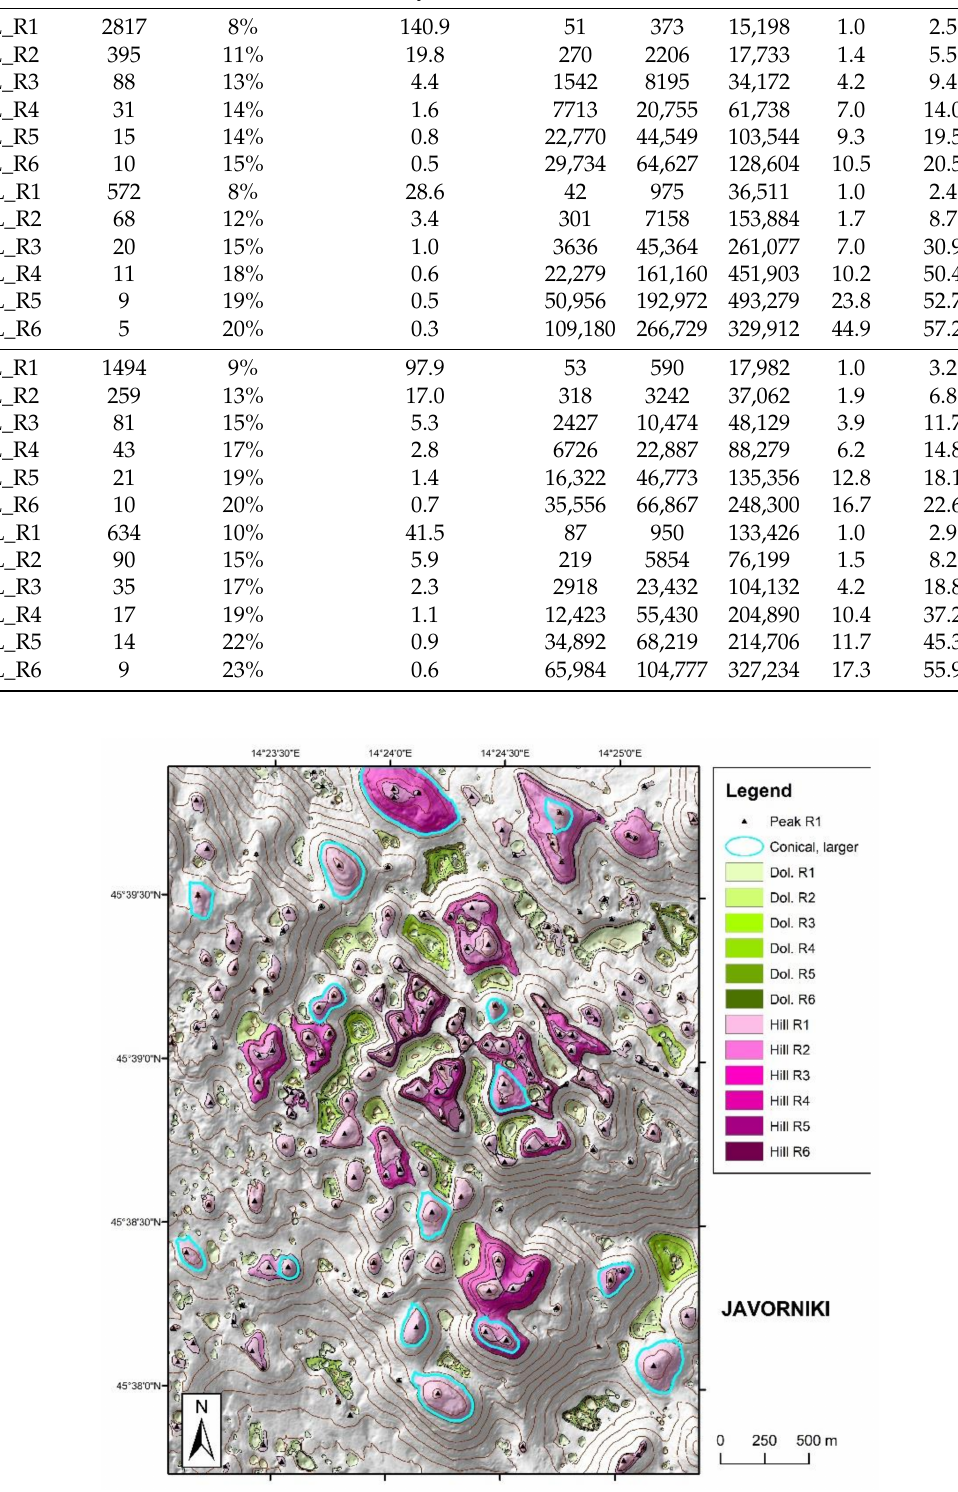
Figure 3. Hillshade map of the Javorniki study area with dolines and karst hills of different ranks. Hills highlighted by cyan outlines are the more circular and larger conical hills (circularity > 0.7, height > 20 m). For further explanation see the Results section in text. Contour interval is 10